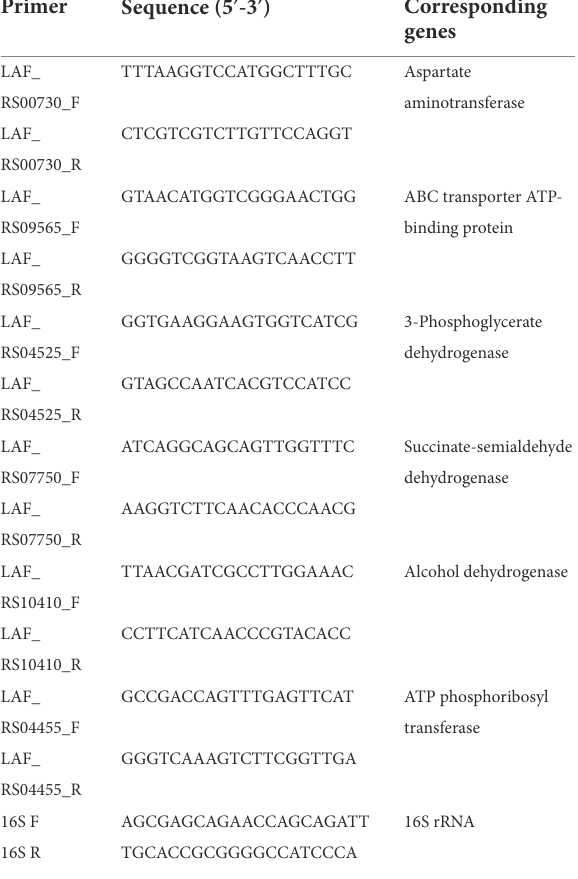
TABLE 1 Primer used for qRT-PCR analysis of genes transcription in Lactobacillus helveticus. Primer Sequence (5 ′ -3 ′